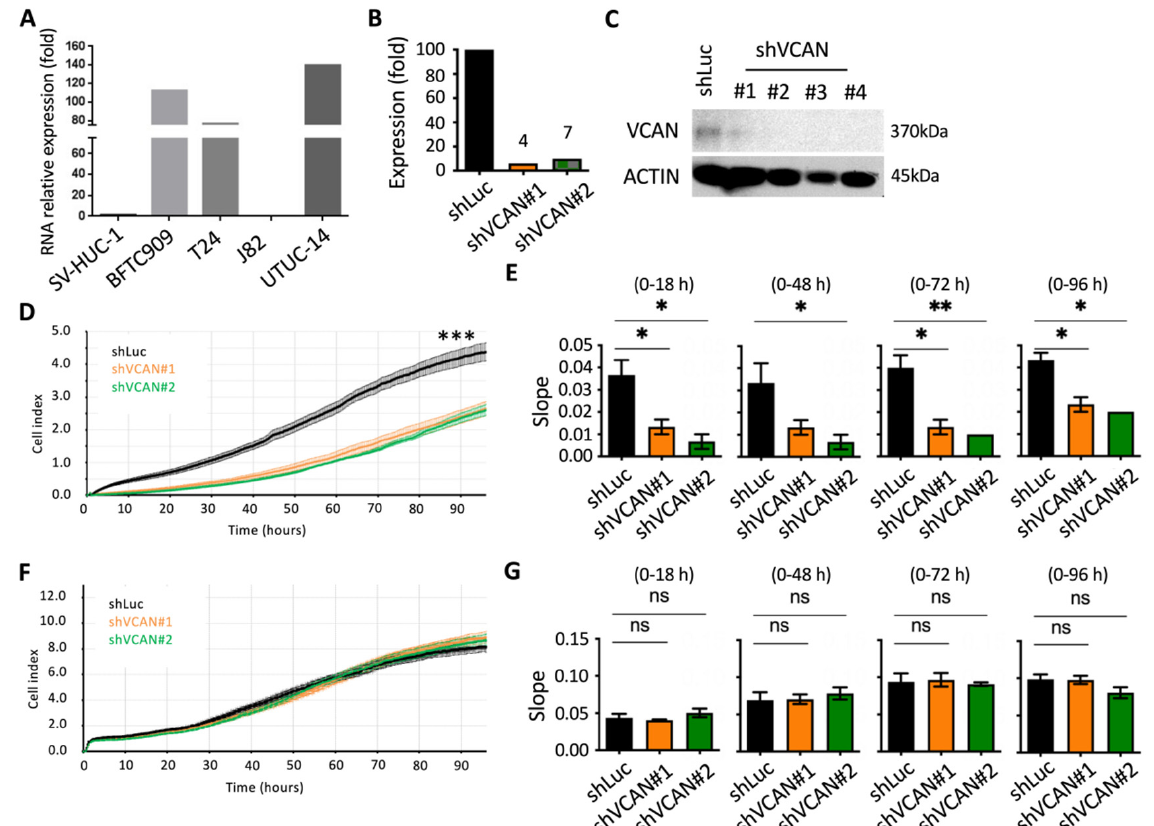
Figure 5. VCAN promoted the migration of cancer cells from UTUC. ( A ) VCAN expression was analyzed in different urothelial cancer cell lines using quantitative PCR. ( B ) The VCAN gene was silenced using shRNA (shVCAN#1 and shVCAN#2) in BFTC909 cells, as determined by qPCR. ( C ) Western blot analysis was used to confirm VCAN silencing. ( D , E ) The migration of BFTC909 cells with shLuc, shVCAN#1 and shVCAN#2 was measured using an RTCA assay. ( F , G ) Cell proliferation was measured in BFTC909 cells with shLuc, shVCAN#1 and shVCAN#2 using an RTCA assay. Statistical analysis was performed by using one-way ANOVA with Tukey’s multiple comparisons test. ns, not significant; * p < 0.05; ** p < 0.01; *** p < 0.001.